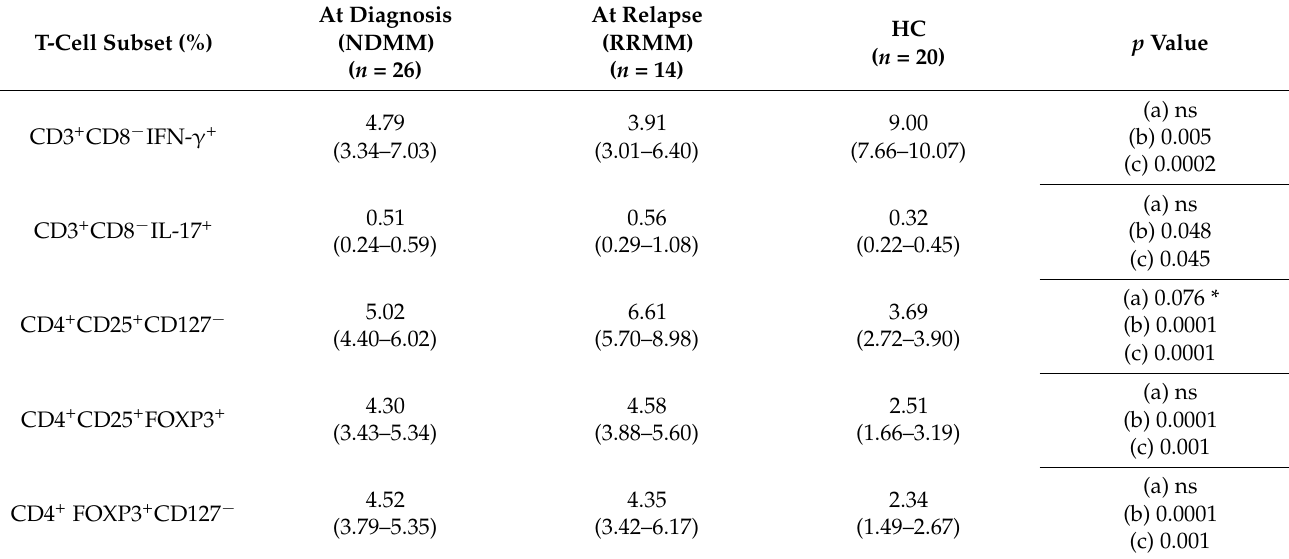
Table 3. Frequency of CD4 T cells secreting inflammatory cytokines and Treg cells in different MM phases and healthy controls (HC).